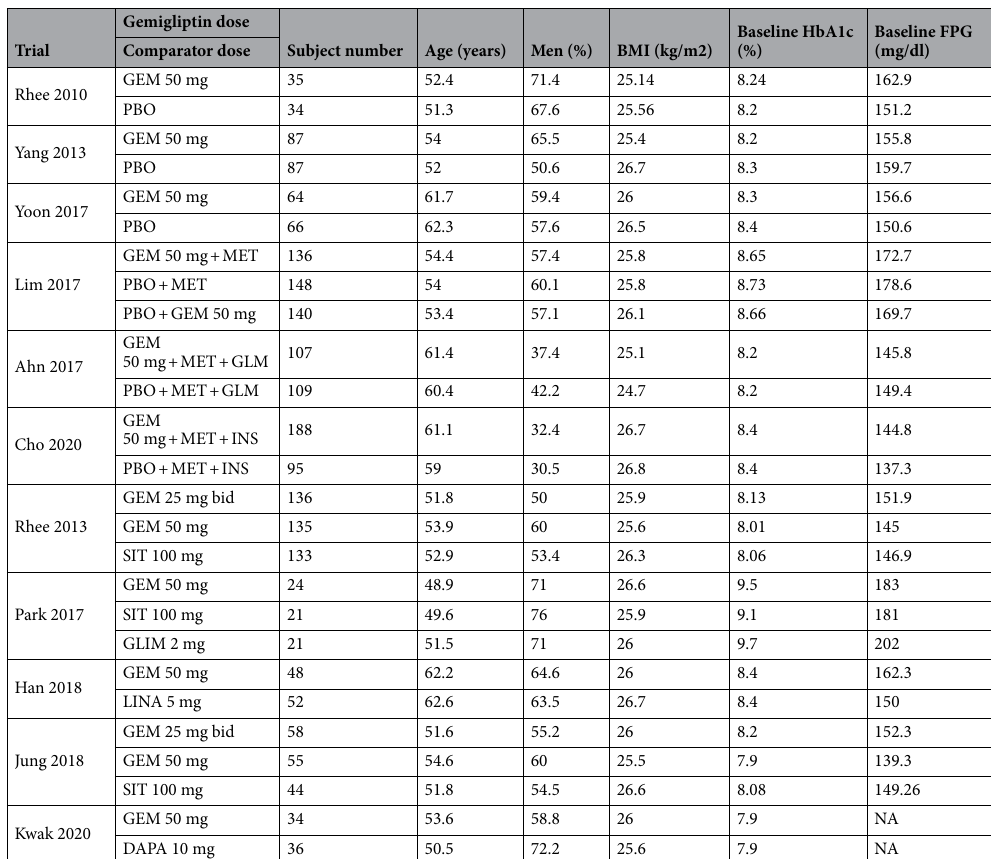
Table 3. Subject demographics of the 11 selected RCTs. GEM gemigliptin, SIT sitagliptin, LINA linagliptin, MET metformin, GLIM glimepiride, DAPA dapagliflozin, INS insulin, bid twice a day.